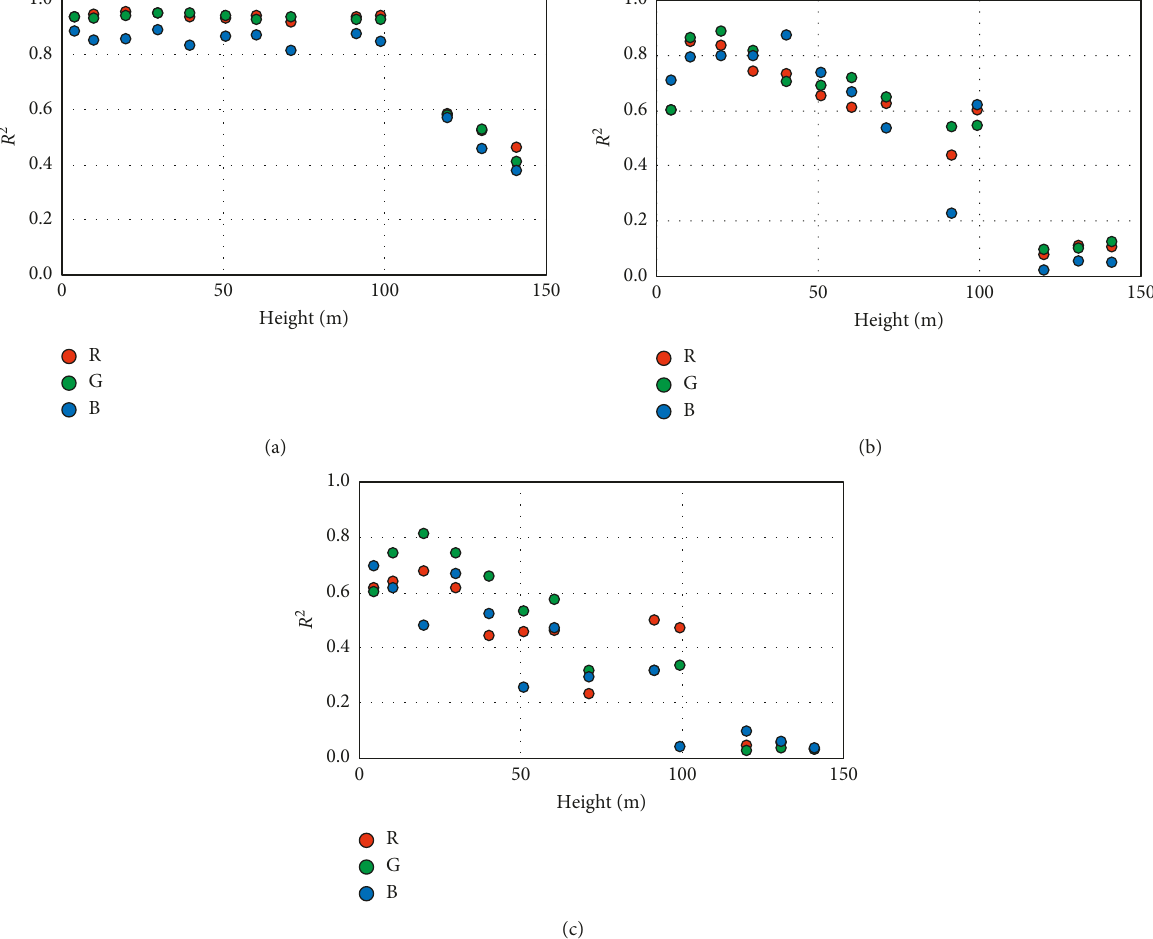
Figure 7: Change of coefficient of determination between the water content and RGB values according to the altitude. Water content range: (a) 1.1 ∼ 30.8%; (b) 18.4 ∼ 24.2%; (c) 24.2 ∼ 30.8%. Table 1: Coefficient of the water estimation formula using RGB values.